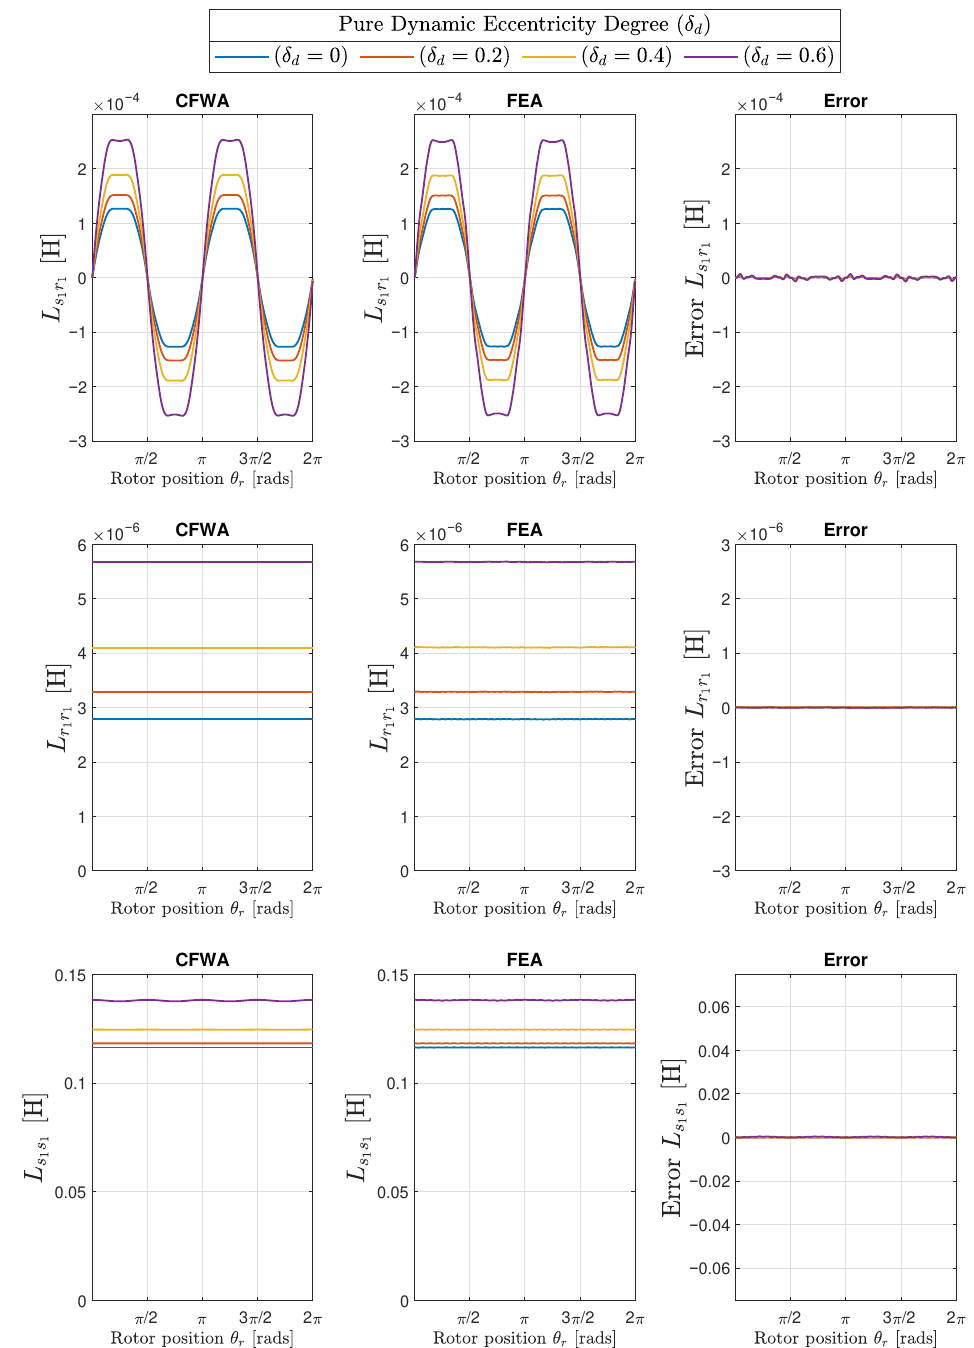
Figure 19. Mutual inductance between the first stator and the first rotor phase ( L s , top row ) and 1 r 1 self-inductances of the first rotor phase ( L r , middle row ) and of the first stator phase ( L s , bottom 1 r 1 1 s 1 row ) for the IM of Appendix A with three different degrees of dynamic ( δ d ) eccentricity: δ d = 0.2, δ d = 0.4, and δ d = 0.6. The case of healthy machine δ d = 0.0 has also been included for comparative purposes. The first column presents the results obtained with the conformal winding tensor approach, the second column presents the results obtained with FEA, and the third column presents the errors between both